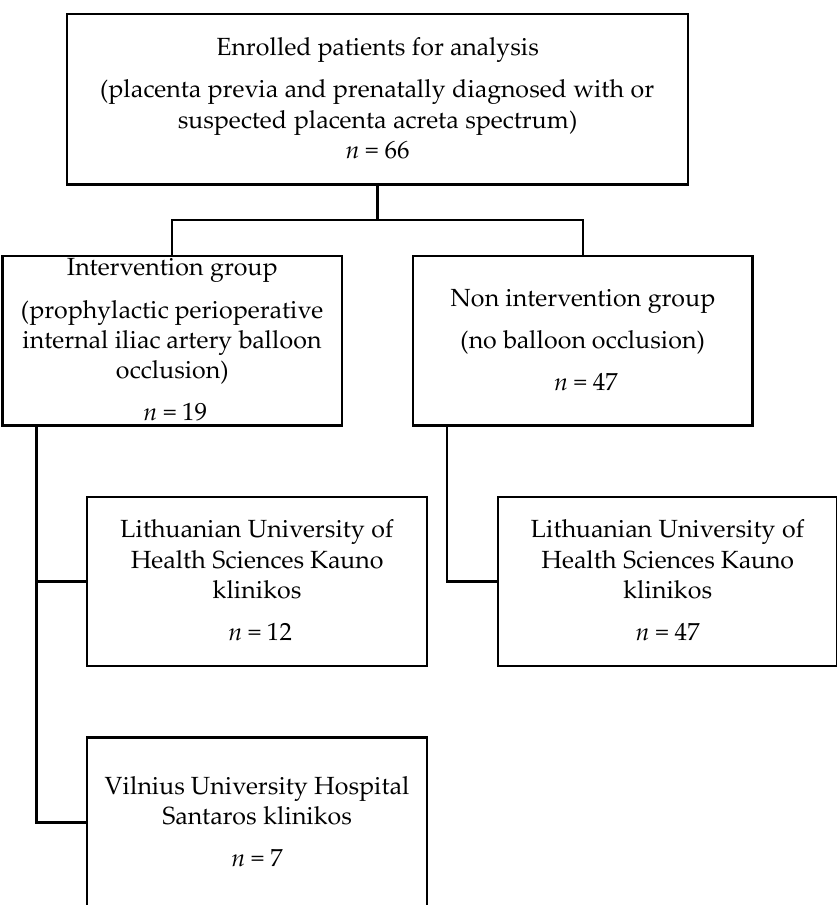
Figure 1. Flow diagram of cases selected for analysis. Study involved patients ( n = 66) from two tertiary Lithuanian hospitals with confirmed placenta previa and with suspected or diagnosed with placenta accreta spectrum.